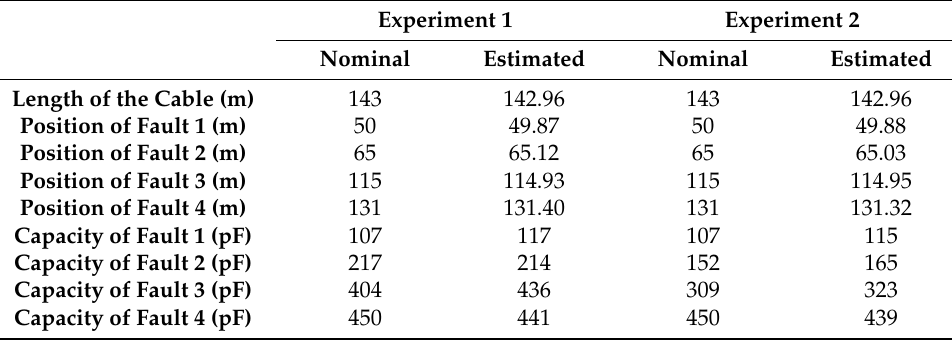
Table 7. Estimation results for real cables with four capacitive